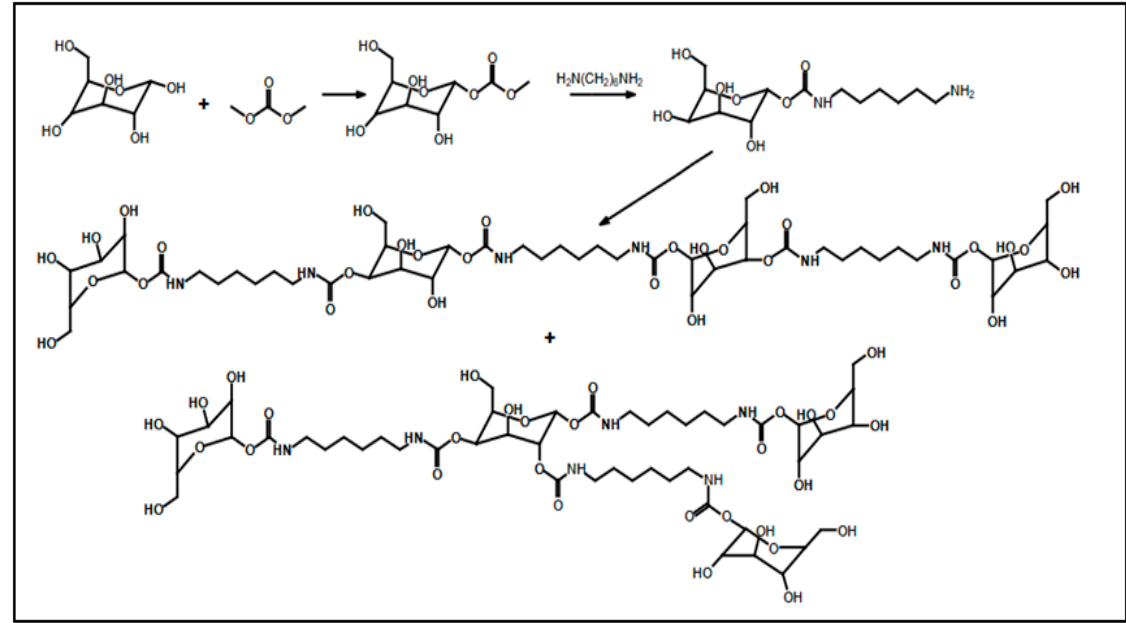
Figure 8. The formation of linear and branched tetramer biobased NIPUF generated from glucose. Reprinted from ref [18] with permission from the publisher.